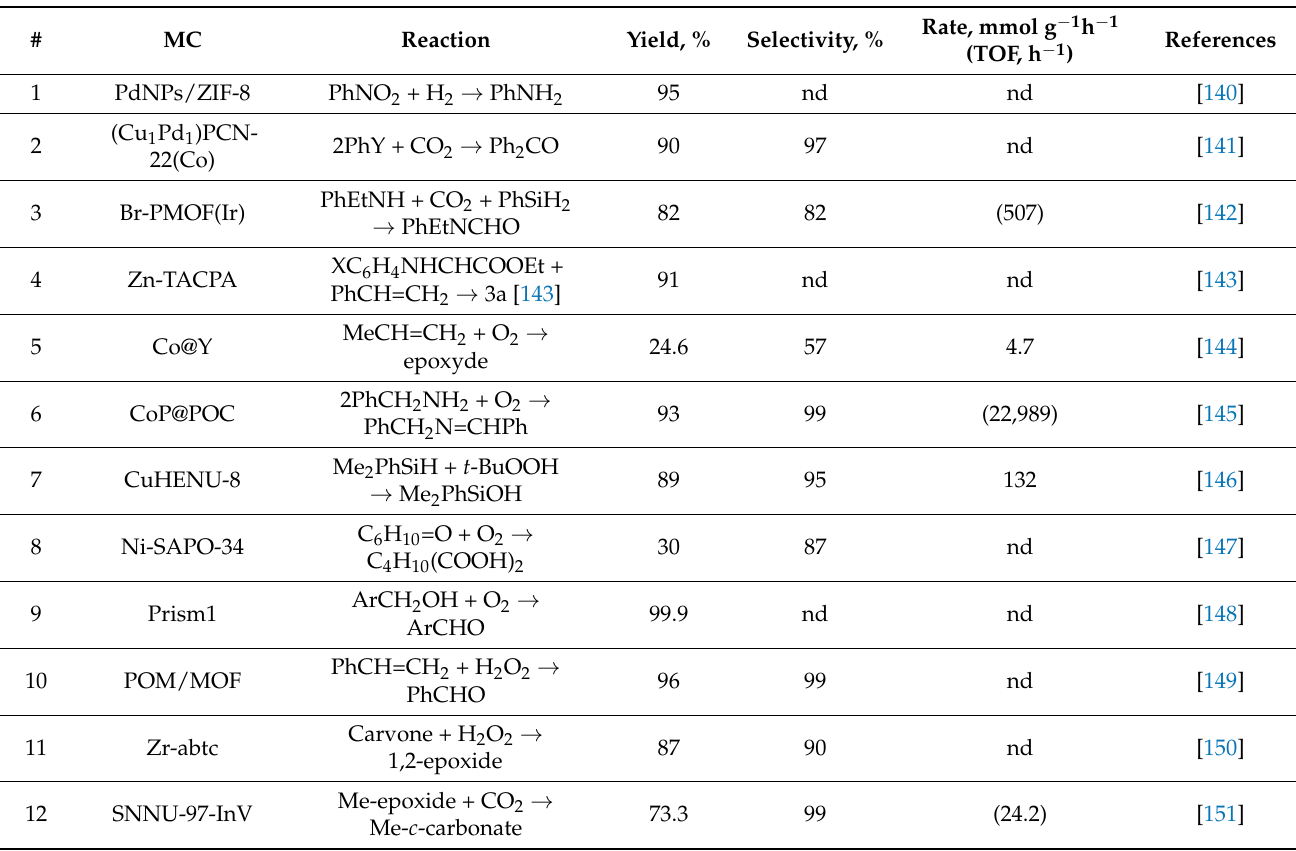
Figure 17. The artificial binuclear copper monooxygenase in a Ti MOF, the central circle shows the structure of the Cu bi-nuclear active site. Reprinted with permission from (Feng X. et al., 2021) [112]. Copyright 2021 American Chemical Society. Table 3. Catalysts for fine organic